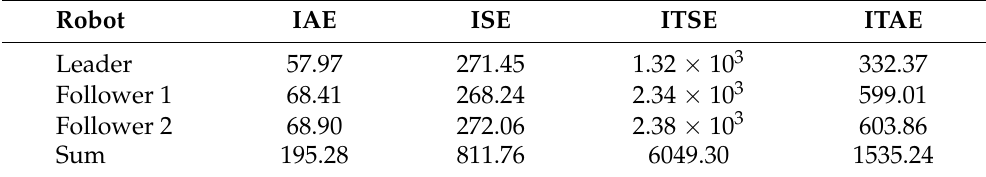
Table 4. Performance indexes for the Villela algorithm in the formation control experiment.